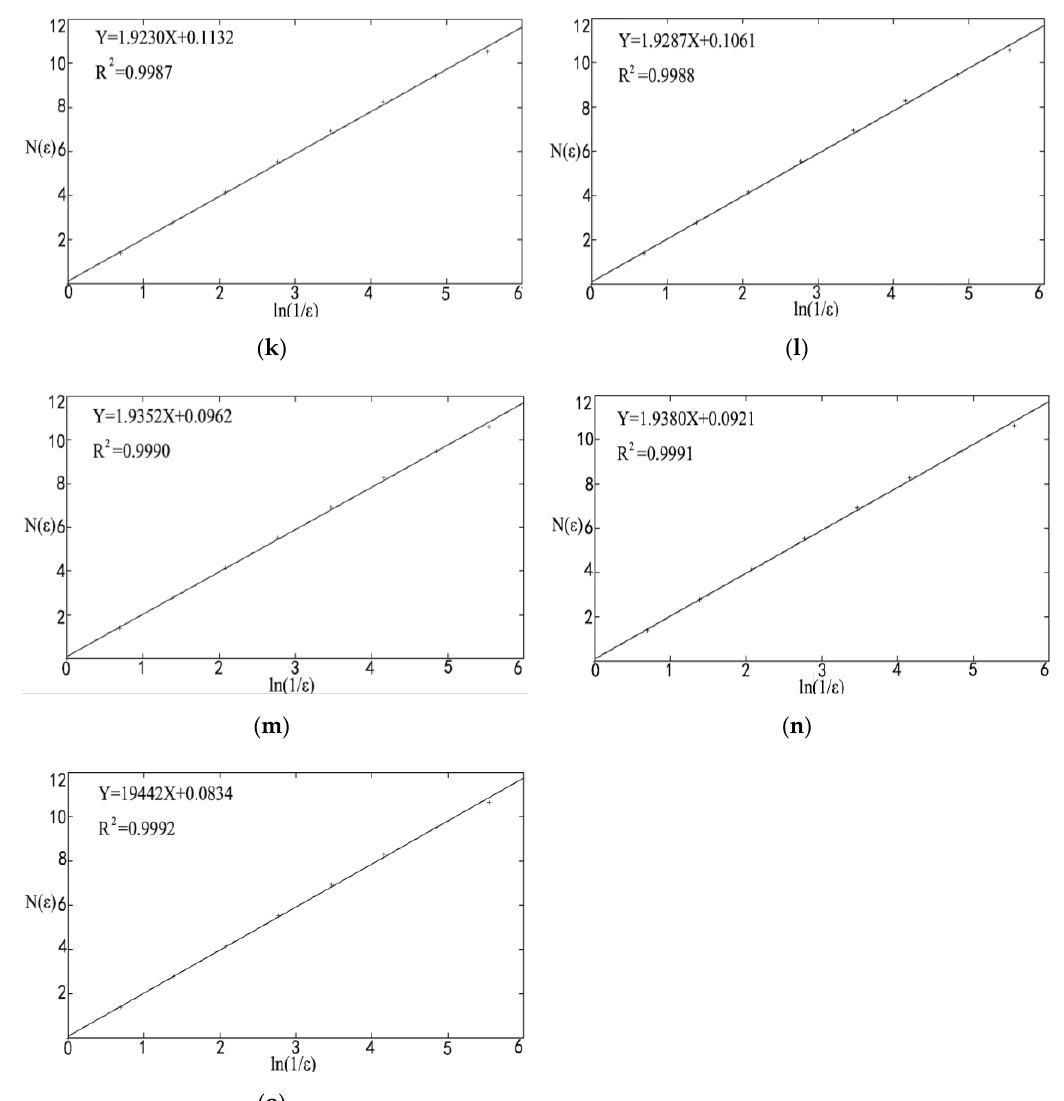
Figure A2. ( a ) Fractal dimension diagram with 25% fiber ( b ) Fractal dimension diagram with 35% fiber ( c ) Fractal dimension diagram with 45% fiber ( d ) Fractal dimension diagram with 55% fiber ( e ) Fractal dimension diagram with 65% fiber ( f ) Fractal dimension diagram with density of 0.076 g/cm 3 ( g ) Fractal dimension diagram with density of 0.102 g/cm 3 ( h ) Fractal dimension diagram with density of 0.127 g/cm 3 ( i ) Fractal dimension diagram with density of 0.153 g/cm 3 ( j ) Fractal dimension diagram with density of 0.178 g/cm 3 ( k ) Fractal dimension diagram with thickness of 10 mm ( l ) Fractal dimension diagram with thickness of 15 mm. ( m ) Fractal dimension diagram with thickness of 20 mm ( n ) Fractal dimension diagram with thickness of 25 mm ( o ) Fractal dimension diagram with thickness of 30 mm 3. Binary images of poplar seed fiber/PCL Composite materials processed under different parameters (a – o).